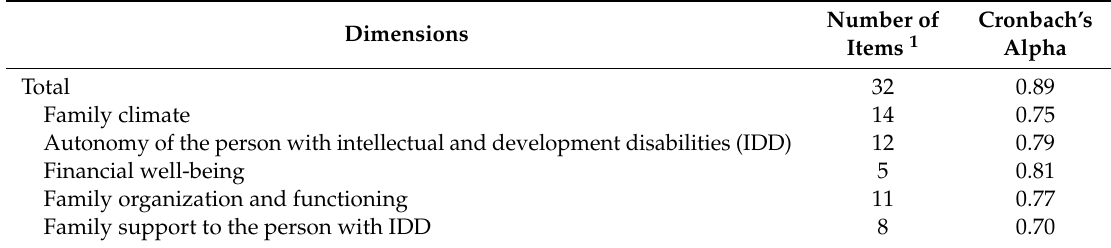
Number of Cronbach’s Items 1 Alpha